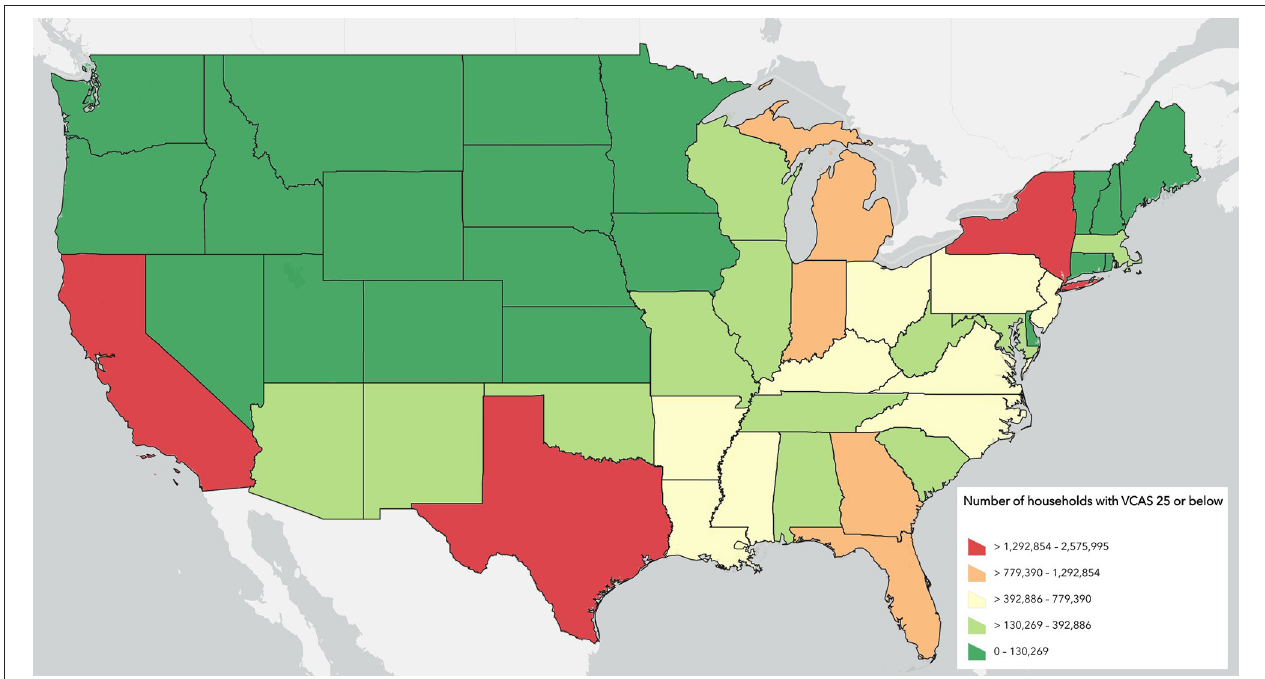
FIGURE 4 | Count of Households in each state that fall within counties in the lowest quartile of the Veterinary Care Accessibility